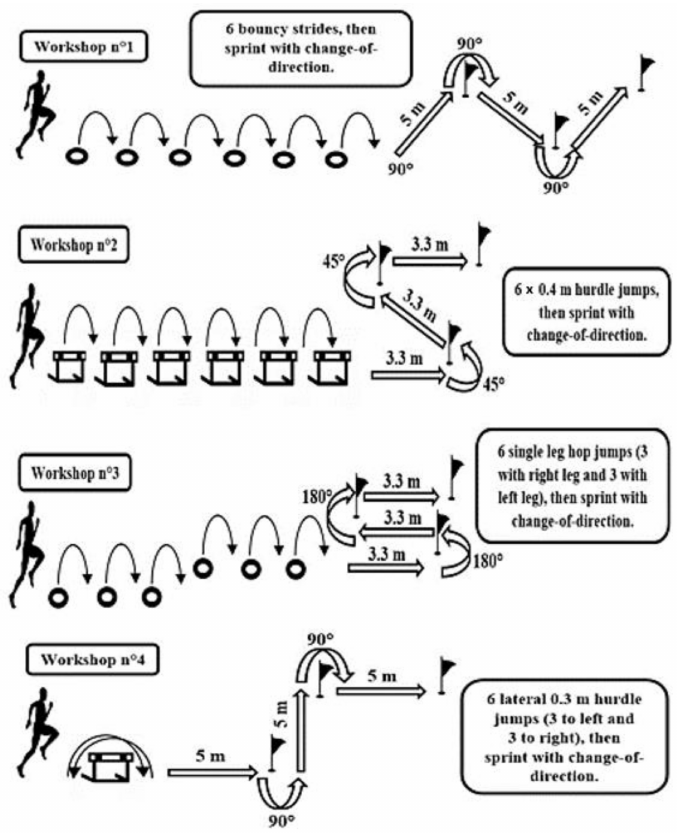
Figure 1. Exercise used in combined plyometric and sprint with a change-of-direction training